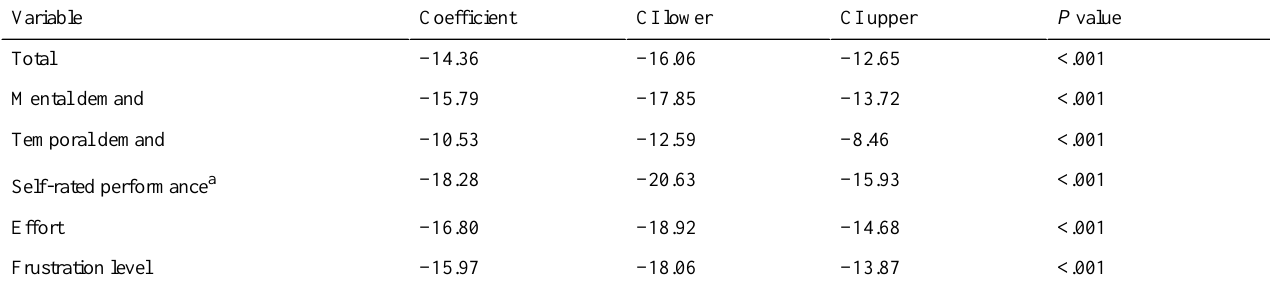
P valueCI upperCI lowerCoefficientVariable